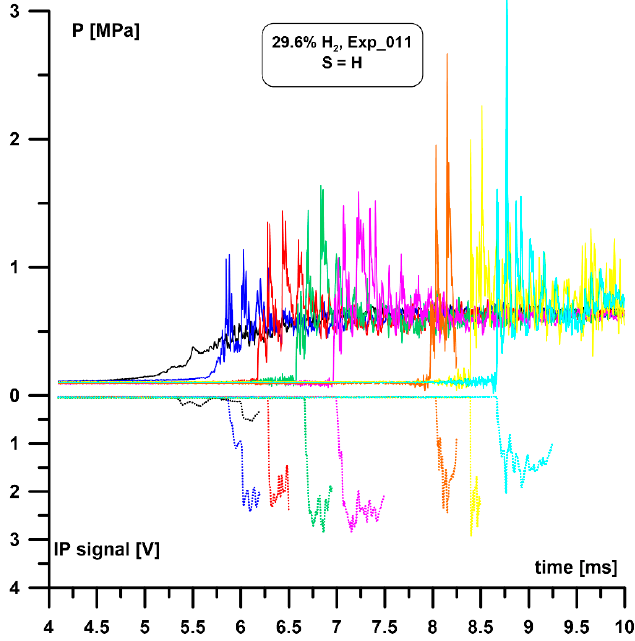
Figure 3. Experimental pressure sensors and ion probes profiles for 29.6% H 2 in air ( φ = 1.0) case S = H. Sequence of sensors activation corresponds to the order of sensors position as in Figure 1. Same colors apply to pressure sensors (top) and ion probes (bottom) at the same position.